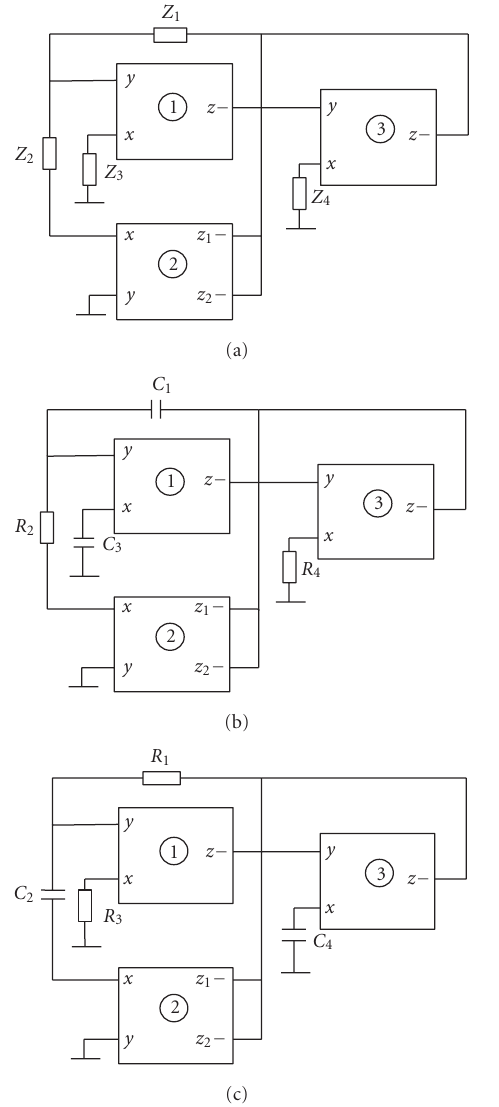
Figure 1: (a) First proposed circuit topology, (b) Type2 oscillator, and (c) Type1 oscillator.